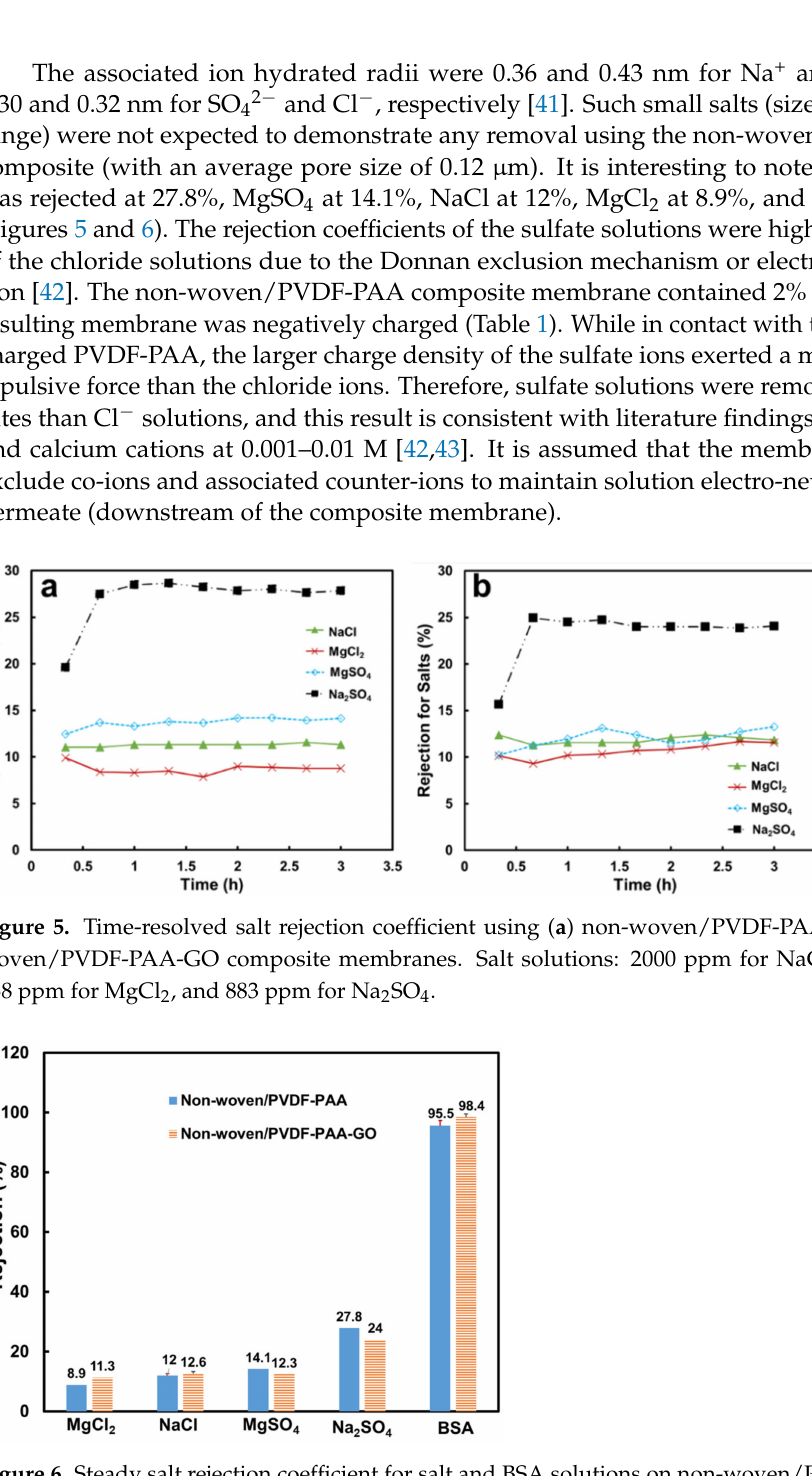
Figure 6. Steady salt rejection coefficient for salt and BSA solutions on non-woven/PVDF-PAA and non-woven/PVDF-PAA-GO composite membranes. Salt solutions: 2000 ppm for NaCl and MgSO 4 , 938 ppm for MgCl 2 , and 883 ppm for Na 2 SO 4 ; BSA solution: 500 ppm. The error bars in NaCl and BSA are 95% confidence intervals based on two replicates (n =